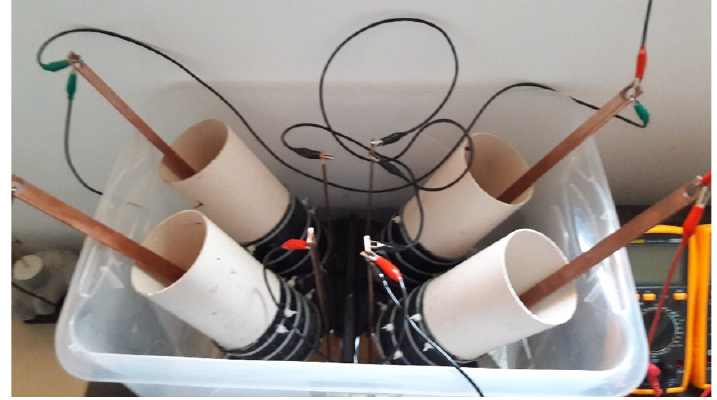
Figure 3. Execution of the NT Build 492 test